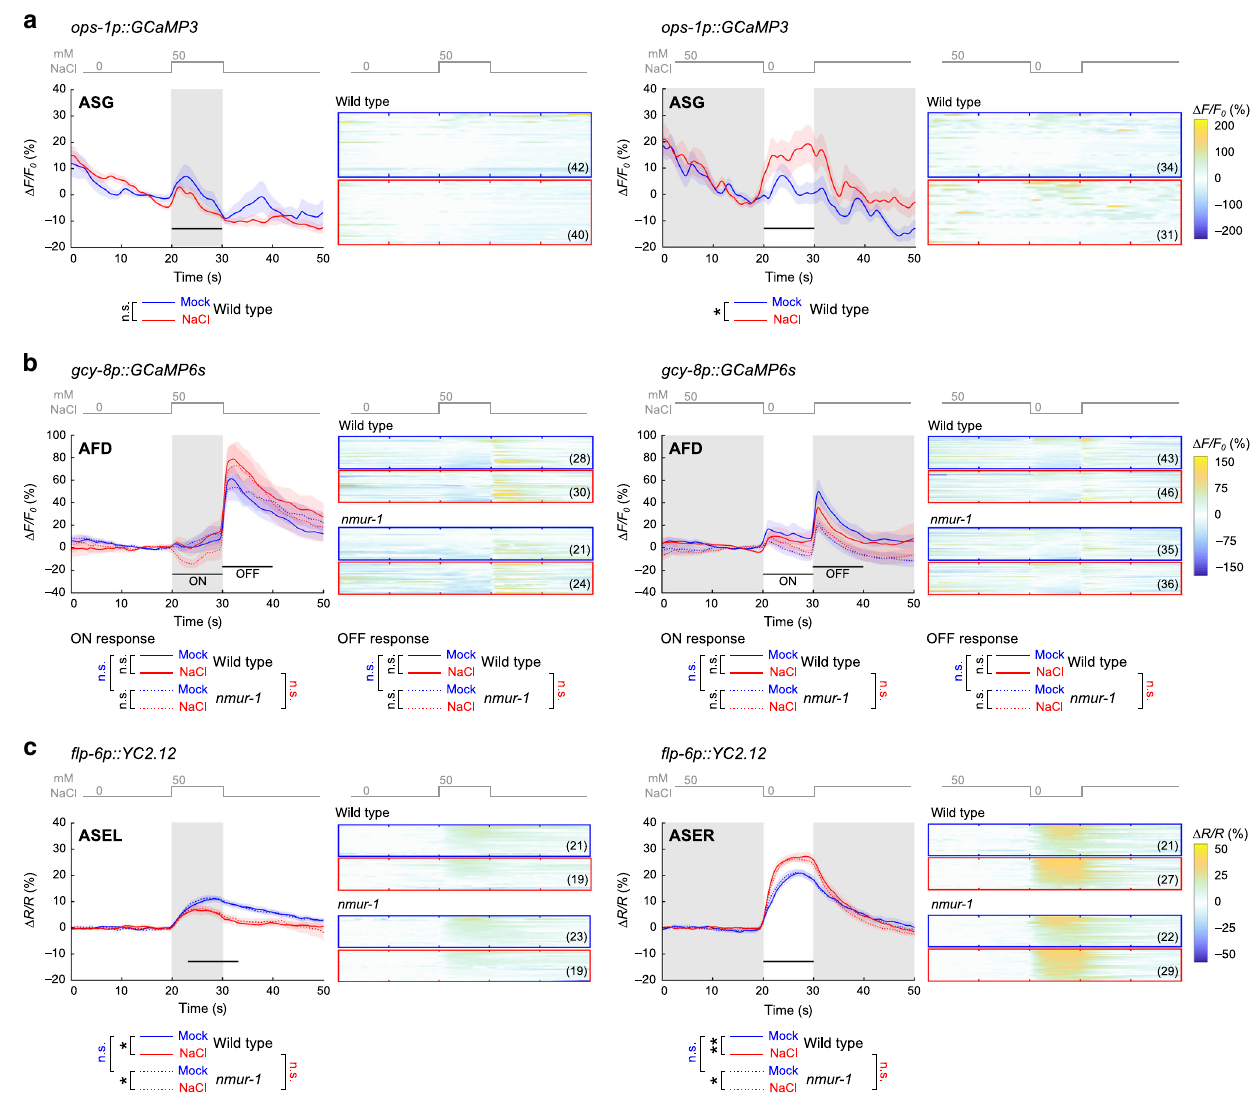
Fig. 6 Aversive NaCl conditioning sculpts calcium responses of ASG neurons to salt stimuli. NaCl-induced calcium responses of selected neurons in mock- and NaCl-conditioned animals. Animals are challenged to a 0 – 50 mM NaCl upshift (left panels) or a 50 to 0 mM NaCl downshift (right panels) after pre-exposure to 0 mM NaCl (mock-conditioned, blue traces) or 100 mM NaCl (NaCl-conditioned, red traces) for 15 min without food. Gray shading indicates exposure to 50 mM NaCl while shaded areas around the average traces indicate the S.E.M. Black horizontal bars show the time interval used for statistical comparison. Heat maps display all individual calcium traces for each condition. Number of animals pictured on each heat map. a NaCl-induced calcium responses in ASG neurons of mock- and NaCl-conditioned wild-type animals measured using the GCaMP3 indicator 54 . Calcium dynamics are relative to 10 s pre-stimulus control values, Δ F/F 0 . Signi fi cances determined by two-tailed Mann – Whitney U test. n.s. not signi fi cant; * p ≤ 0.05. b NaCl- induced calcium responses in AFD neurons of mock- and NaCl-conditioned wild-type or nmur-1 (lst1672) animals expressing the GCaMP6s calcium indicator in AFD 59 . Calcium dynamics are relative to 10 s pre-stimulus control values, Δ F/F 0 . Signi fi cances determined by two-sided Kruskal – Wallis test. n. s. not signi fi cant. c NaCl-induced calcium responses in ASE neurons of mock- and NaCl-conditioned wild-type or nmur-1 (ok1387) animals expressing the YC2.12 indicator in ASE 62 . Traces indicate the average percent change in the ratio of the distinct wavelengths of the YC2.12 indicator, Δ R/R. Signi fi cances determined by one-way ANOVA with Tukey ’ s multiple comparison test. n.s. not signi fi cant; * p ≤ 0.05; ** p ≤